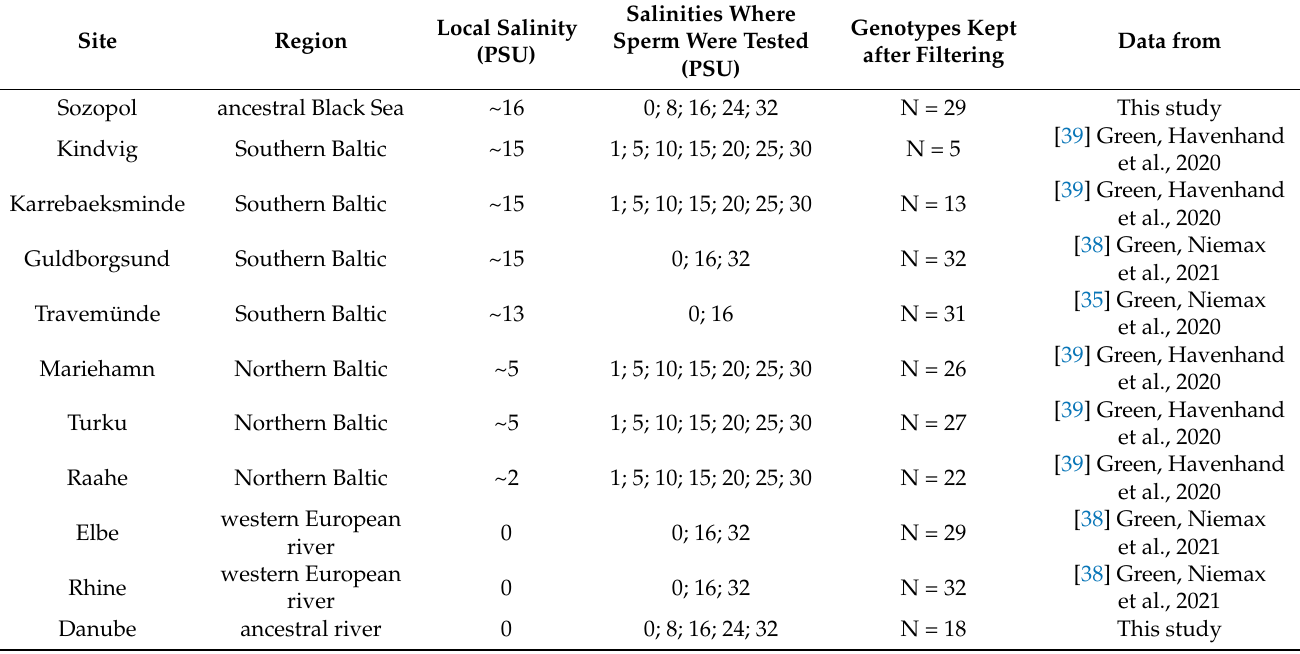
Table 1. Sites, their metadata, sources and summary of phenotypes and genotypes of round gobies ( Neogobius melanostomus ) used for this study. The sites are sorted according to salinity. Coordinates and details of genotype acquisition are available in Supplementary Table